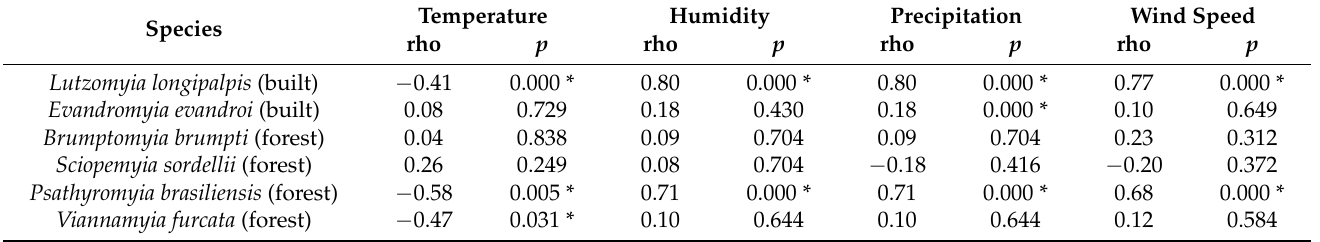
Figure 4. Abundance of sand flies in forest and built areas during capture months. Table 4. Spearman’s correlation results between the most frequent species in the forest areas and built areas with environmental conditions, of João Pessoa, Paraíba, Brazil.